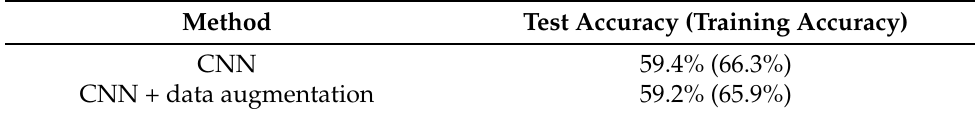
Table 9. Accuracy by age group using virtual human